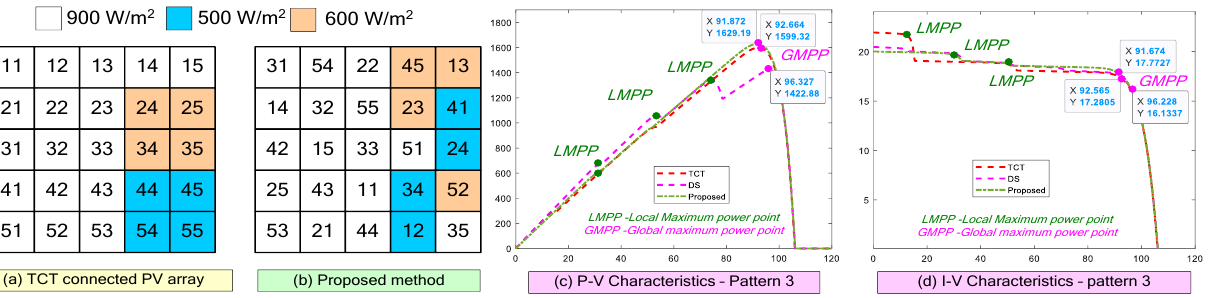
Figure 5. Shade pattern 3 — ( a ) TCT arrangement, ( b ) Proposed arrangement, ( c ) P – V characteristics, ( d ) I – V characteristics. A non-conventional shade pattern, shade pattern 4 would be considered quite unu- sual if it were to happen in reality. In this shade case, the five farthest left PV panels are shaded in the last three columns. Surprisingly, the global power values of the proposed and DS methods are the same, at 1634.28 W; however, TCT only produced 1422.93 W. A 6a,b. In addition, the simulated I – V and P – V characteristics of DS, TCT, and the sum of